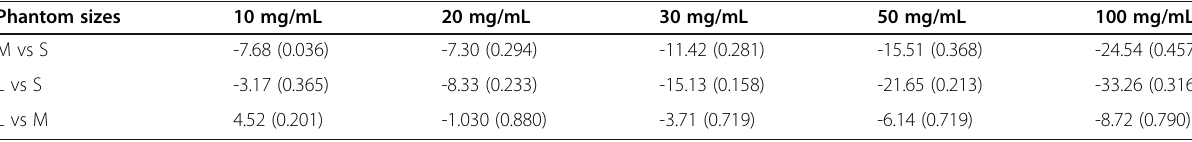
Table 6 Mean difference in HU values between phantom sizes for all monoenergetic images and iodine concentrations with General Electric Revolution CT Phantom sizes 10 mg/mL M vs S L vs